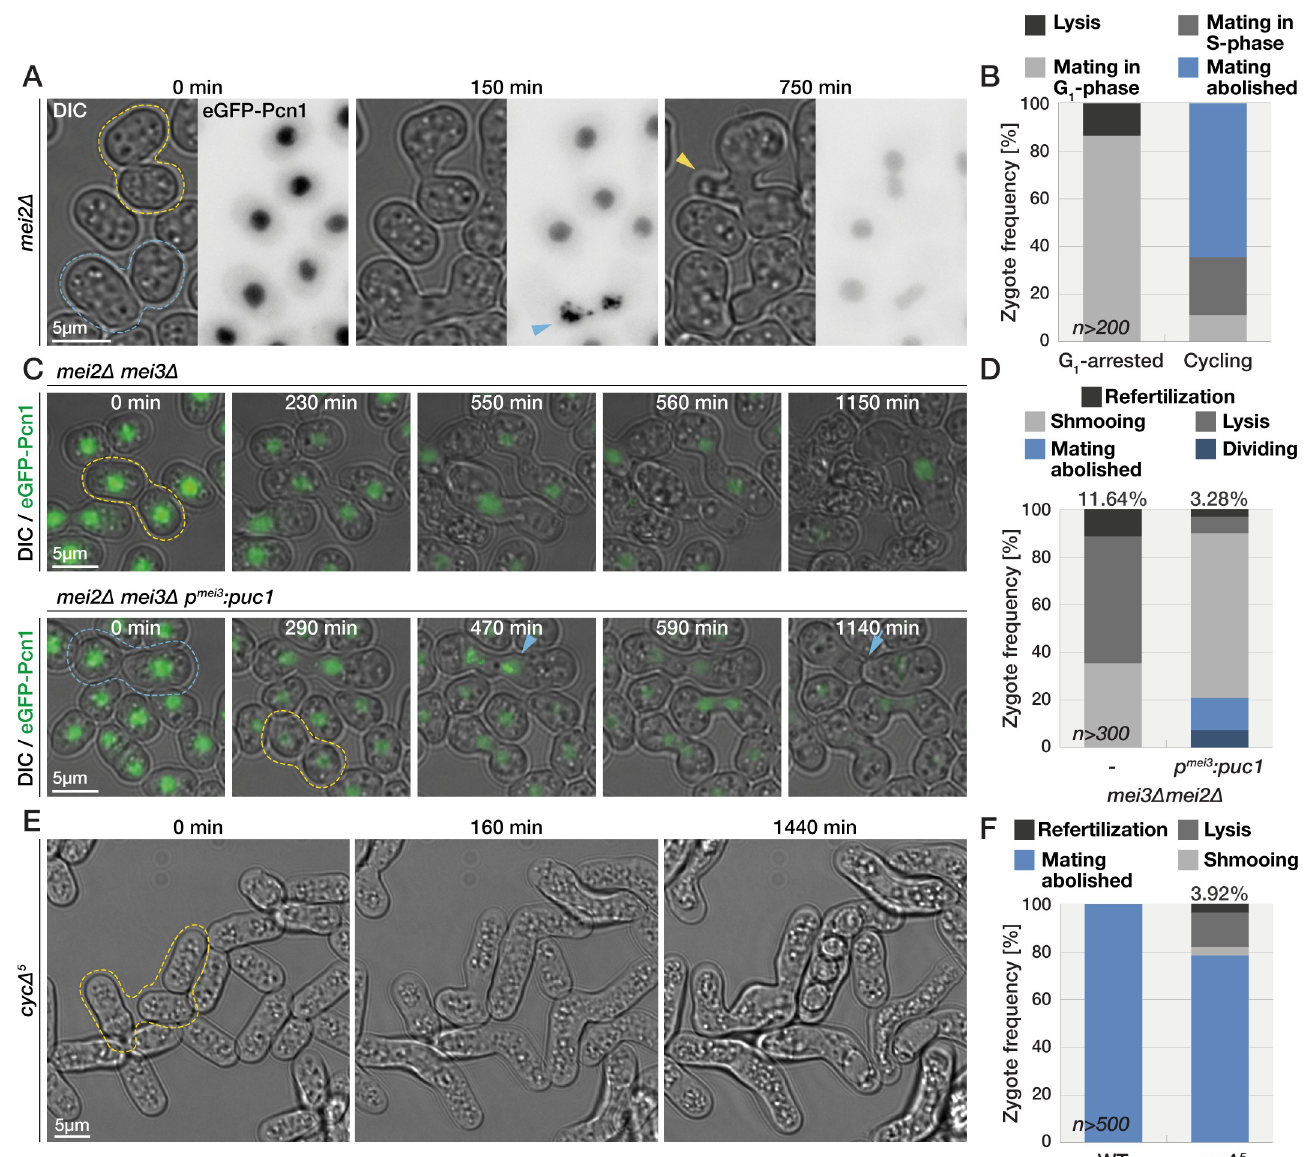
Fig 6. Cell cycle progression prevents refertilization. (A) Time lapse of mating mei2 Δ cells. Zygotes that persist in G1 (yellow outlines) form prominent mating projections (yellow arrowhead). Zygotes that progress through S-phase (blue outlines), evident from GFP-Pcn1 puncta (blue arrowhead), largely repress shmoo formation and instead divide. (B) Quantification of phenotypes of mei2 Δ zygotes presented in (A). We used GFP-Pcn1 to group zygotes into those that either arrest (left bars) or exit (right bars) G1-phase and scored the mating behaviors of both groups. (C) Mating of control mei3 Δ mei2 Δ cells (top panel) and mei3 Δ mei2 Δ cells that express Puc1 from the zygote-specific p mei3 promoter. GFP-Pcn1 (green) forms puncta (blue arrowhead) in Puc1-expressing zygotes (blue outlines). G1-arrested zygotes (yellow outlines) frequently lyse in control but not Puc1-expressing zygotes. (D) Quantification of zygotic phenotypes observed in time lapses as in (D). (E) Mating of cyc Δ 5 cells, which undergo refertilization (yellow outlines). (F) Quantification zygotic phenotypes observed in (E). The data underlying this Figure may be found at